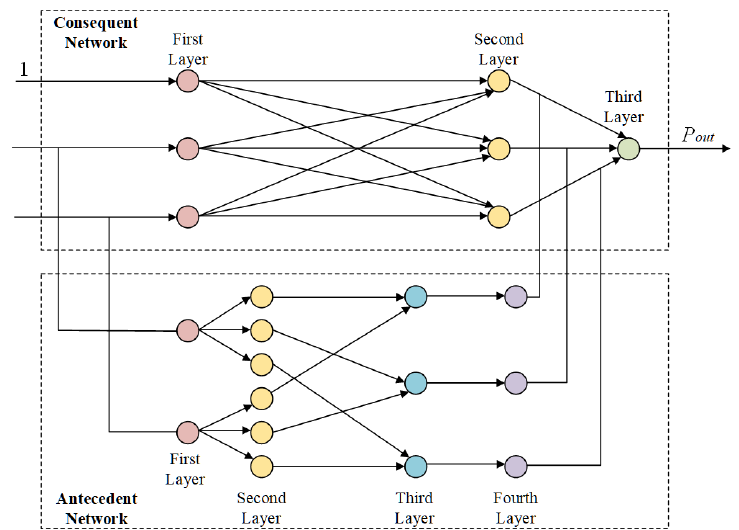
Figure 10. Fuzzy neural network controller structure.